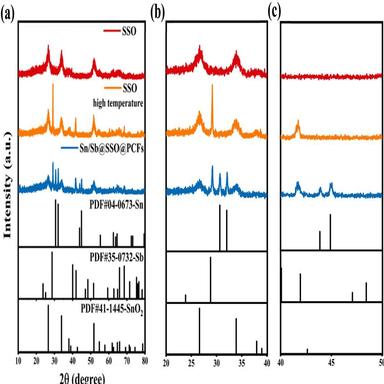
(a-c) XRD patterns of SSO, SSO-high temperature, Sn/Sb@SSO@PCFs at (a) 10–80°, (b) Enlarged region 20–40°, (c) Enlarged region 40–50°.